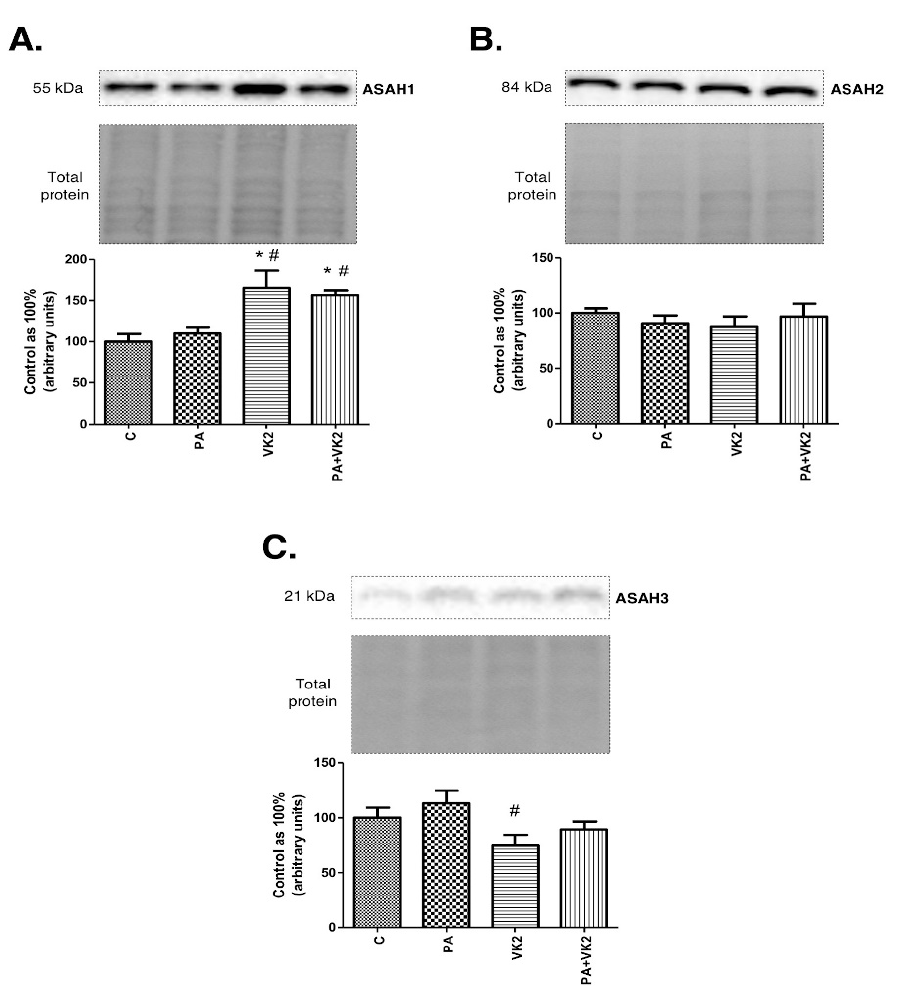
Figure 3. Intracellular expression of acid ceramidase (ASAH1) ( A ), neutral ceramidase (ASAH2) ( B ) and alkaline ceramidase (ASAH3) ( C ) in HepG2 cells. The cells were incubated for 16 h with palmitic acid and/or vitamin K2. The expression of enzymes from ceramide catabolism pathway was assessed by Western blotting as described in the Materials and Methods section. The results are presented as mean ± SD and are based on six independent determinations. *— P < 0.05 signifi- cant difference vs control group, #— P < 0.05 significant difference vs palmitate group;